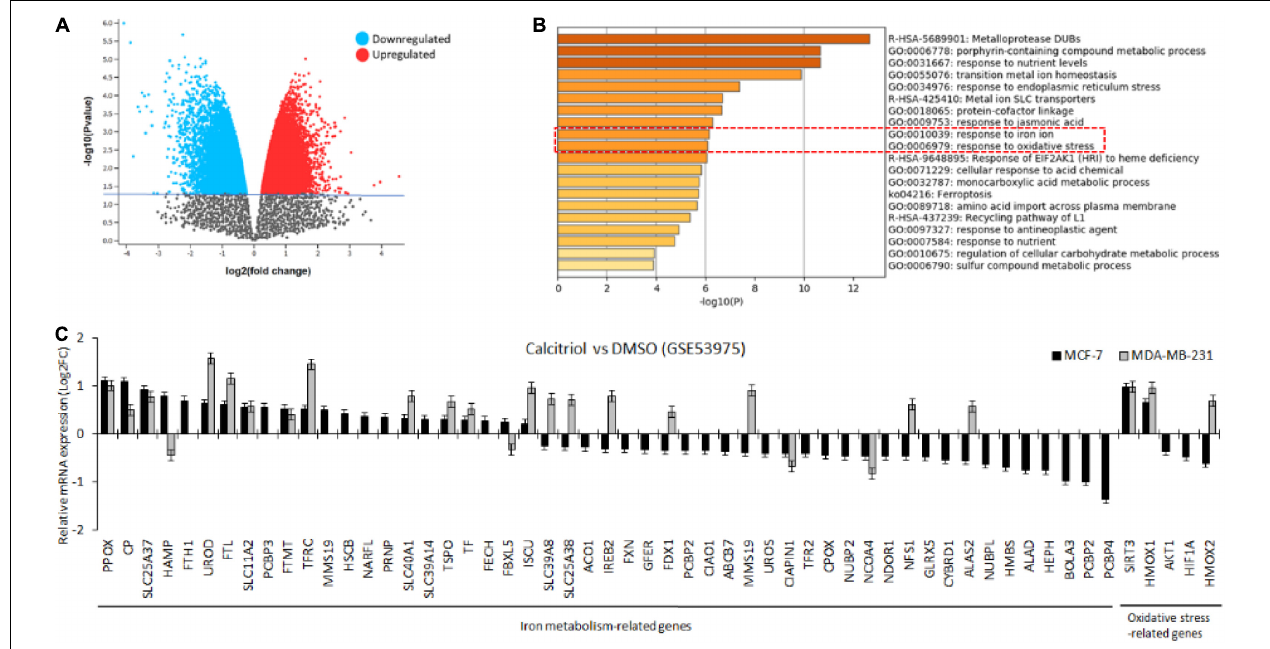
FIGURE 1 | In silico analysis to investigate the effect of vitamin D treatment on breast cancer cells. (A) Volcano plot showing more than 5,000 genes were significantly up-/downregulated in MCF-7 and MDA-MB-231 cells. (B) Pathway analysis of differentially expressed genes showing enrichment of pathways related to the response to iron ion and oxidative stress. (C) Bar graph plot showing the mean expression values of iron metabolism and oxidative stress-related genes for both cell lines treated with calcitriol compared with DMSO-treated cells.